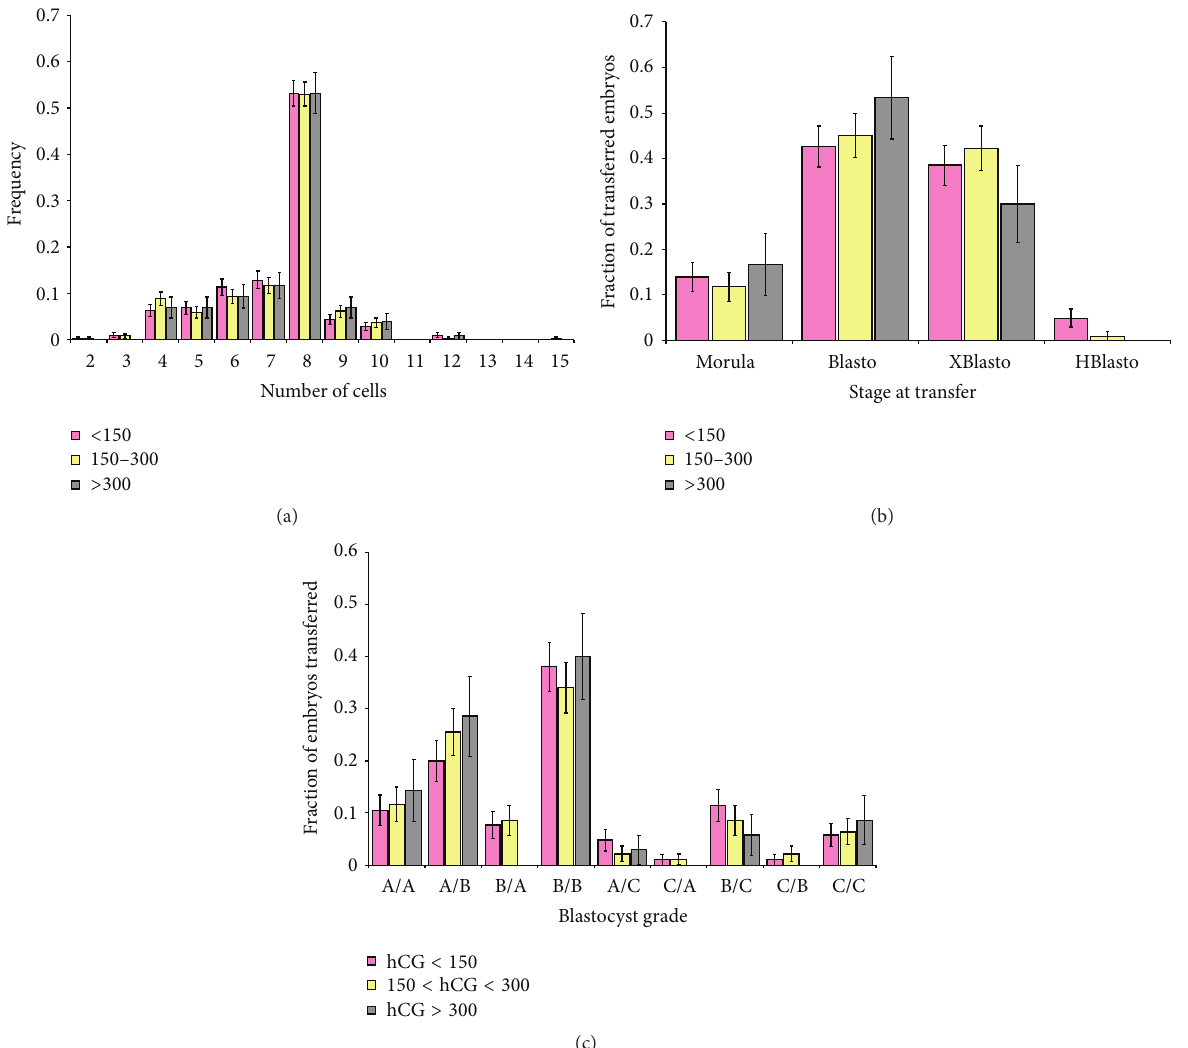
Figure 1: Postovulatory serum hCG levels and embryo quality. Bars indicate the incidence (frequency) of embryos with specified numbers of cells transferred on day 3 (a), embryo stage transferred on day 5 (b), and embryo grade transferred on day 5 (c). Error bars represent standard error. Postovulatory serum hCG levels were not associated with the number of cells in day 3 embryos (Contingency Chi Squared, 𝑝 = 0.972 ) (a), the embryo stage in day 5 transfers (Contingency Chi Squared, 𝑝 = 0.399 ) (b), nor the blastocyst grade in day 5 transfers (Contingency Chi Squared, 𝑝 = 0.933